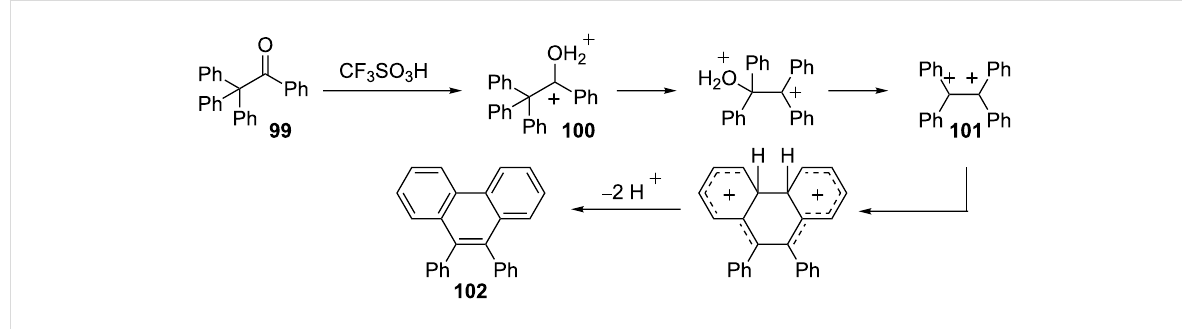
Scheme 21: Rearrangement of a superelectrophilic carboxonium ion 100 .